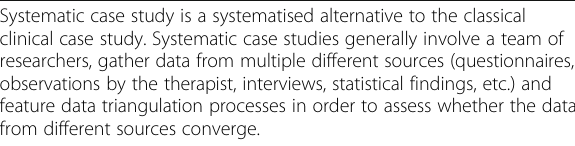
Table 1 Key concept: systematic case study Systematic case study is a systematised alternative to the classical clinical case study. Systematic case studies generally involve a team of researchers, gather data from multiple different sources (questionnaires, observations by the therapist, interviews, statistical findings, etc.) and feature data triangulation processes in order to assess whether the data from different sources converge.